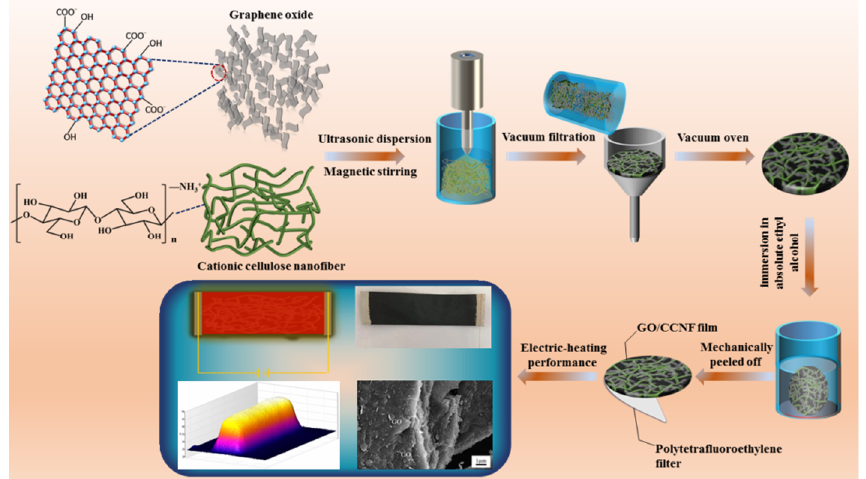
Figure 1. A schematic for preparing method and testing electric-heating performance of GO/CCNF composite films.